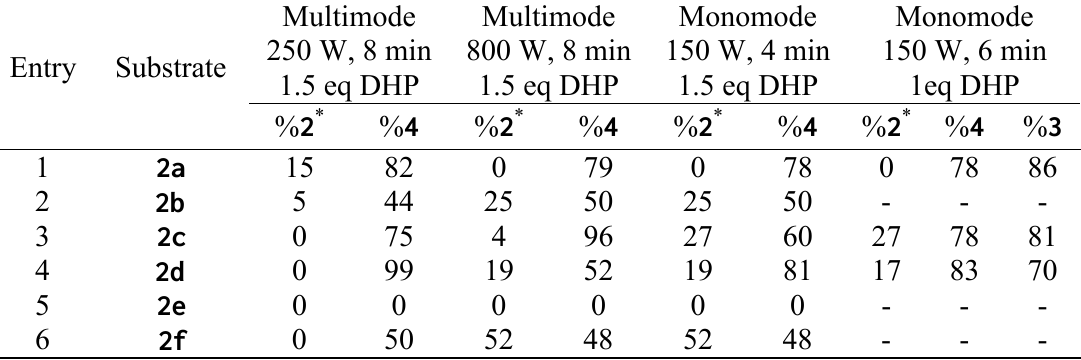
Table 1. Reduction by 1a of carbon-carbon double